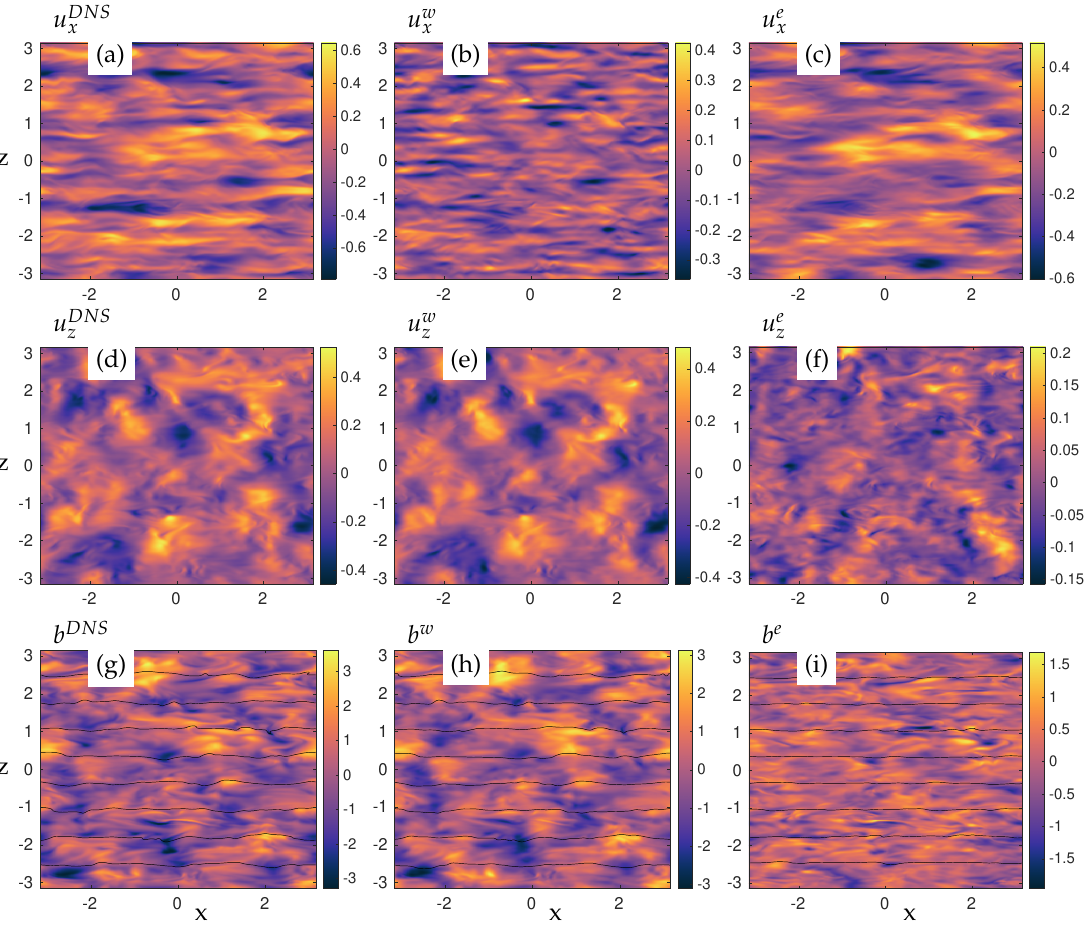
Figure 14. Distributions of horizontal and vertical velocity components, and of buoyancy in the ( x , z ) plane in the middle of the y interval. Numerical simulation has a Kolmogorov length scale of η = 9 × 10 − 3 and a Kolmogorov time scale of τ η = 0.2 ( a – c ) Horizontal velocity component u x . ( d – f ) Vertical velocity component u z . ( g – i ) Buoyancy field, with superimposed iso-density lines in black. The first column ( a , d , g ) is the complete field; the second column ( b , e , h ) is the wave part in the wave-eddy decomposition; and the third column ( c , f , i ) is the eddy